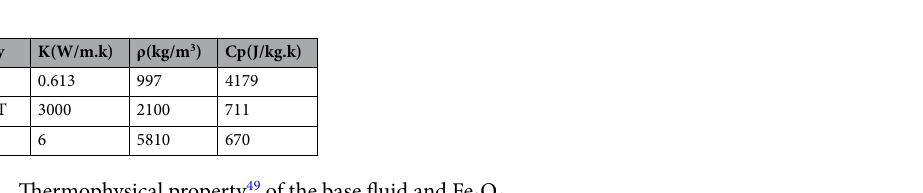
Table 1. Thermophysical property 49 of the base fluid and Fe 3 O 4.